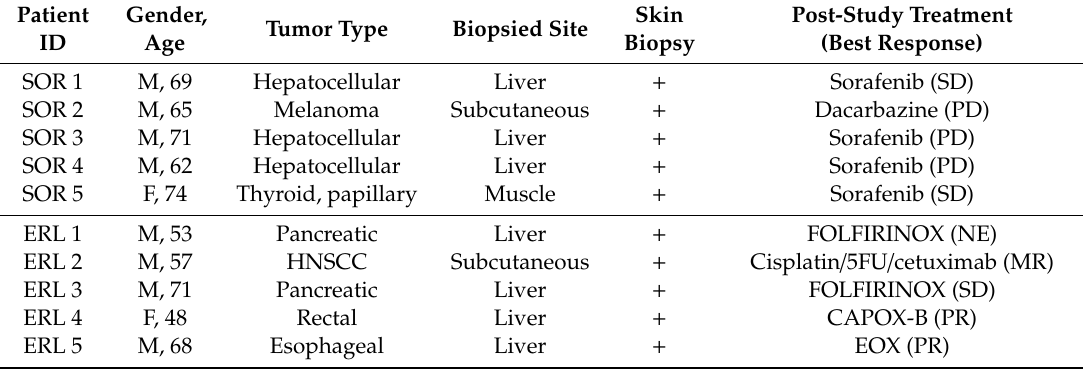
Figure 1. Study design. Patients with advanced solid tumors underwent tumor needle biopsy before and after 10–14 days of treatment with a protein kinase inhibitor, administered as standard treatment for their advanced disease or, off-label, prior to standard palliative chemotherapy. LC-MS/MS ; liquid chromatography coupled to tandem mass spectrometry. Table 1. Patient characteristics. Clinical characteristics of 31 patients in whom an on-treatment biopsy could be obtained. Patient ID: SOR , sorafenib; ERL , erlotinib; DAS , dasatinib; VEM , vemurafenib; SUN , sunitinib; EVE , everolimus. Gender: M , male; F , female. Tumor type: HNSCC , head and neck squamous cell cancer; ACUP , adenocarcinoma of unknown primary origin; (pancreatic) NET , neuroendocrine tumor. Radiological response: SD , stable disease; C / P / MR , complete / partial / mixed response; PD , progressive disease; NE , not evaluable. pTyr phosphoproteomics could not be performed in 2 VEM patients: for VEM1, no pre-treatment tumor biopsy was taken; for VEM2, on-treatment tumor tissue was insufficient for pTyr profiling. On-treatment tumor drug concentration was determined in these patients.